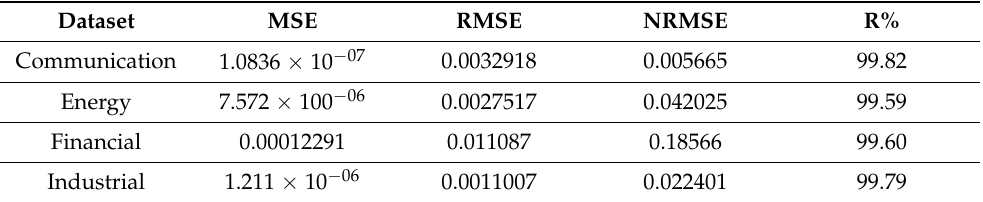
Table 5. Performance of the MLP model in the testing stage. Dataset